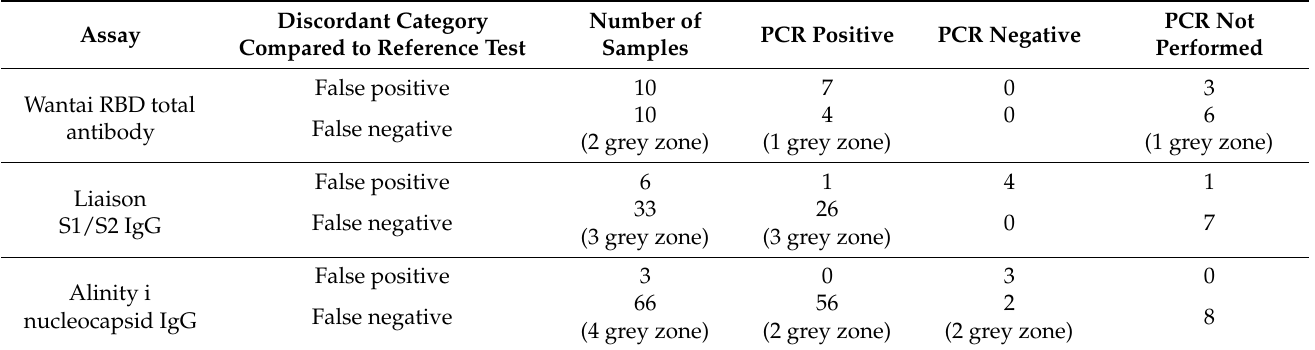
Table 5. Discordant results in the commercial antibody assays when compared to the two-step reference